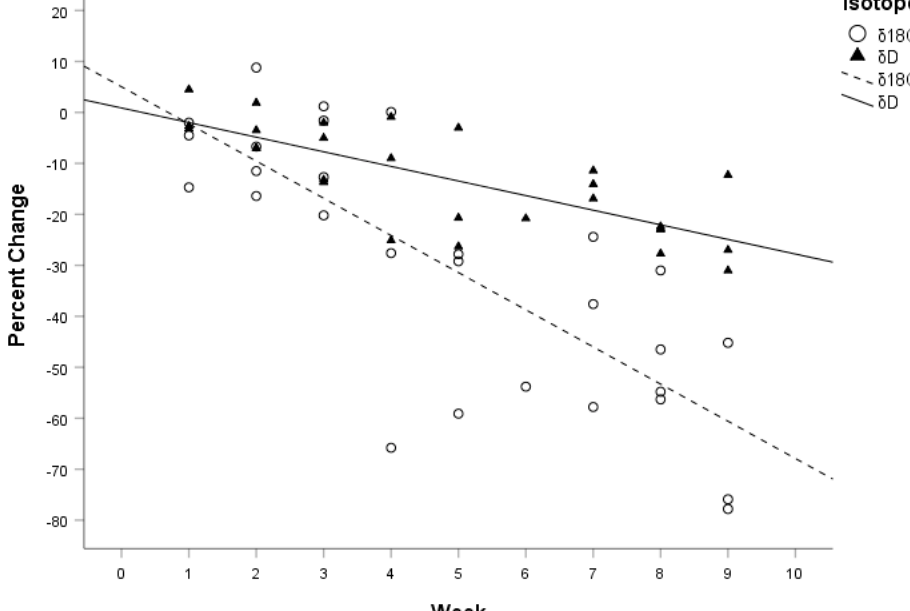
Figure 2. The least-squares regression lines for δ D are indicated by the solid line ( y = 0.00872 − 0.03 x ) and triangles and those for δ 18 O are indicated by the open circles and dashed line ( y = 0.05 − 0.07 x ). Results of the analysis of covariance (ANCOVA) test for homogeneity of slopes found a significant difference in the interaction between isotope and week (F 1,53 = 69.7, p < 0.001), indicating a significant difference in the slopes of the two regression lines. The intercept was not significantly different (F 1,53 = 0.767, p = 0.385). The means of the isotopes were significantly different (F 1,53 = 69.7, p < 0.001). This is consistent with experiments that used doubly labeled water, which showed oxygen isotopes to turn over at a greater rate than hydrogen isotopes.